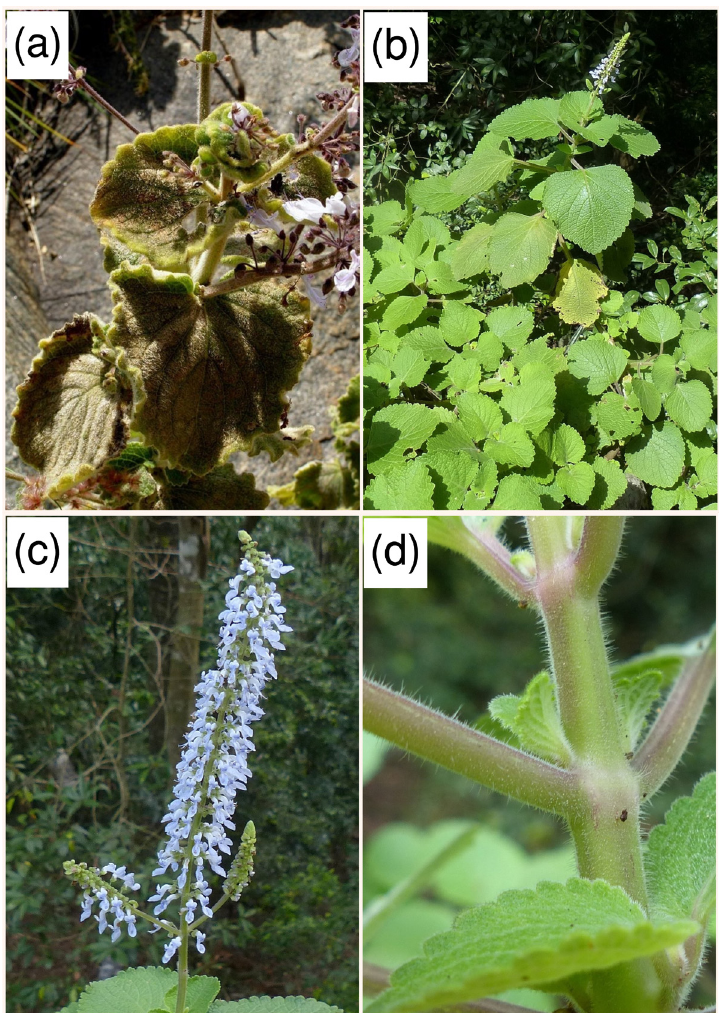
Figure 1: Southern African and Sri Lankan morphs of Plectranthus hadiensis var. tomentosus . (a) The morph from Swaziland, southern Africa (image: K.Braun, Swaziland’s Flora Database, http://www.sntc.org.sz/ flora/photo.asp?phid=5646 , accessed 14 April 2019). (b) Habit, (c) inflorescence, and (d) stem and leaf pubescence of the morph from Sri Lanka (images: P. D. H.